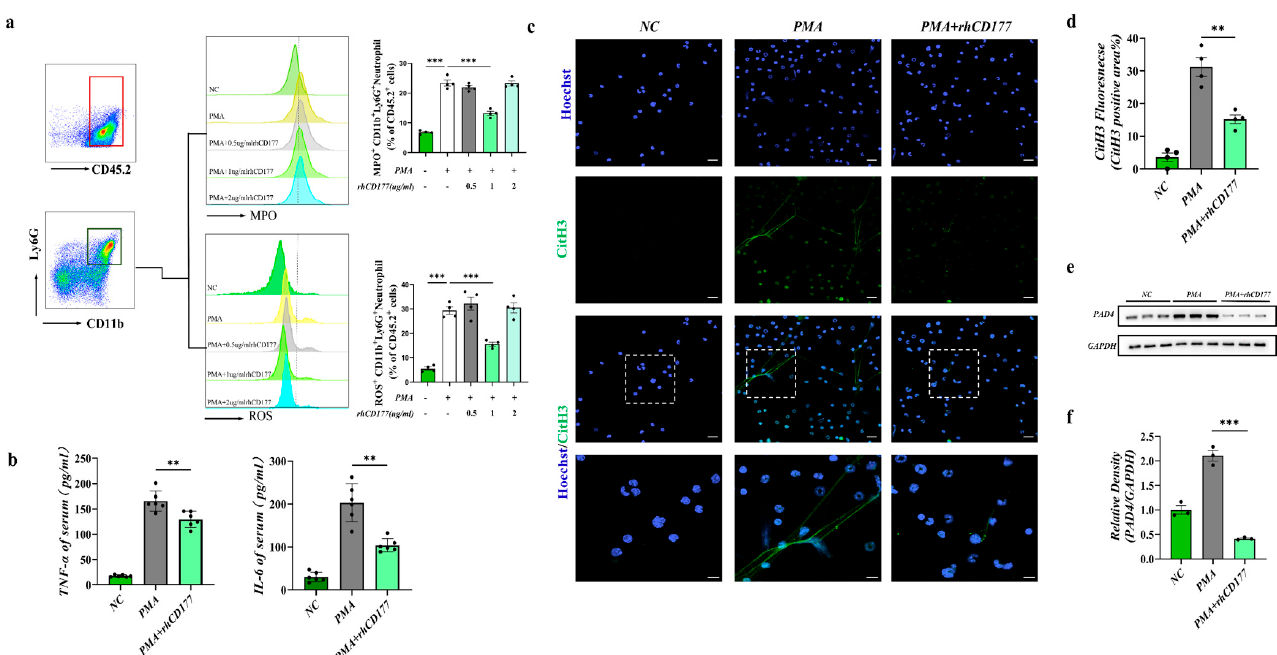
Figure 2. rhCD177 successfully inhibited NET formation. Bone marrow neutrophils isolated from six-to-eight-week-old C57BL/6 mice were cultured and stimulated with PMA (100 nM). ( a ) Representative flow cytometry plots and bar graphs depicting the proportion of neutrophils and the expression levels of MPO and ROS. Data are presented as means ± SEM ( n = 4 per group, gating of CD45.2 + CD11b + Ly6G + ). ( b ) Supernatant levels of IL-6 and TNF- α were detected using ELISA ( n = 6 each group). ( c ) Representative immunofluorescence image of CitH3 in magnification at 600 × and 1000 × ( n = 4 per group). Scale bar = 20 µ M. ( d ) Densitometric analysis of CitH3 fluorescence. ( e ) Western blot analysis of PAD4 levels in neutrophils. ( f ) Relative protein expression of PAD4; GAPDH was used as a control for protein loading. ( n = 3 per group). Black dots represent samples. Statistical signi fi cance is indicated by ** p < 0.01, *** p < 0.001.